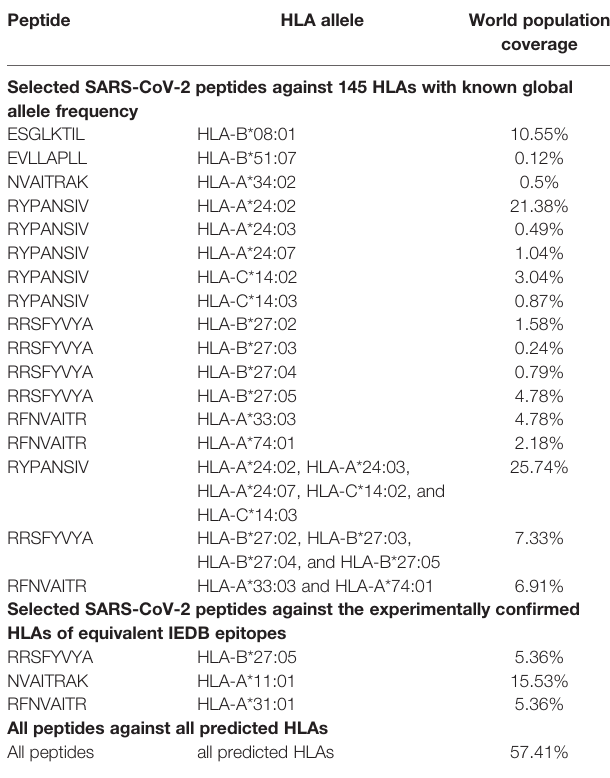
TABLE 5 | The population coverage calculation for peptides with predicted HLA